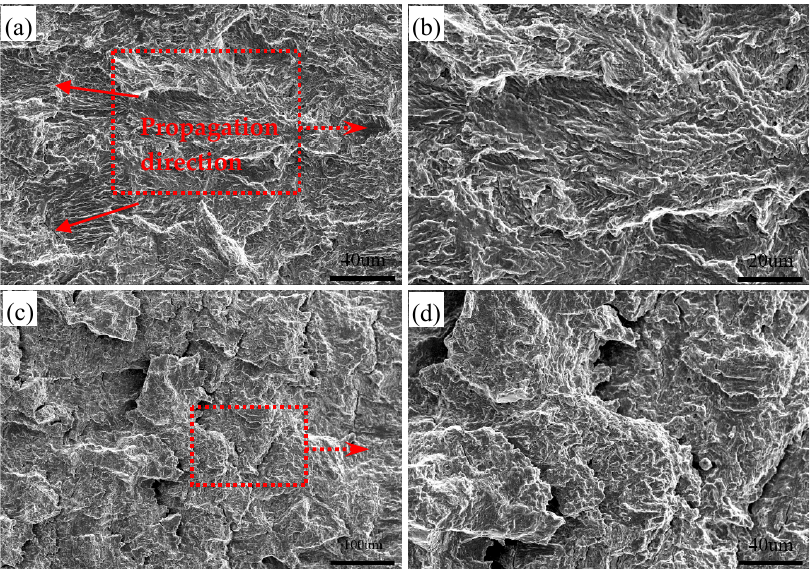
Figure 7. Typical SEM micrographs of fracture surface at peak temperature of 1350 °C. ( a ) the fracture surface in the early stage; ( b ) magnified view of the dashed box in ( a ); ( c ) the area far away from the crack source; ( d ) magnified view of the dashed box in (c).